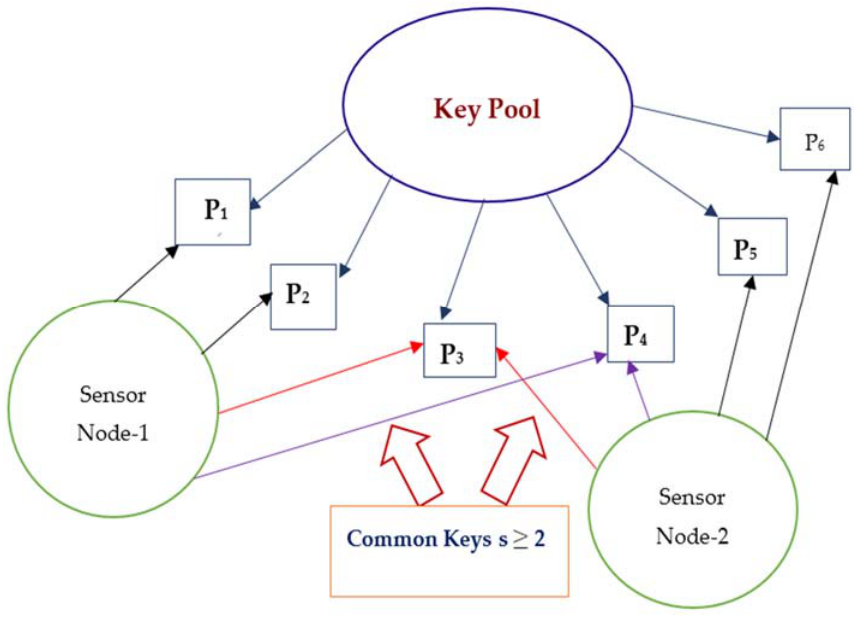
Figure 8. s ‐ Composite Random Key Predistribution